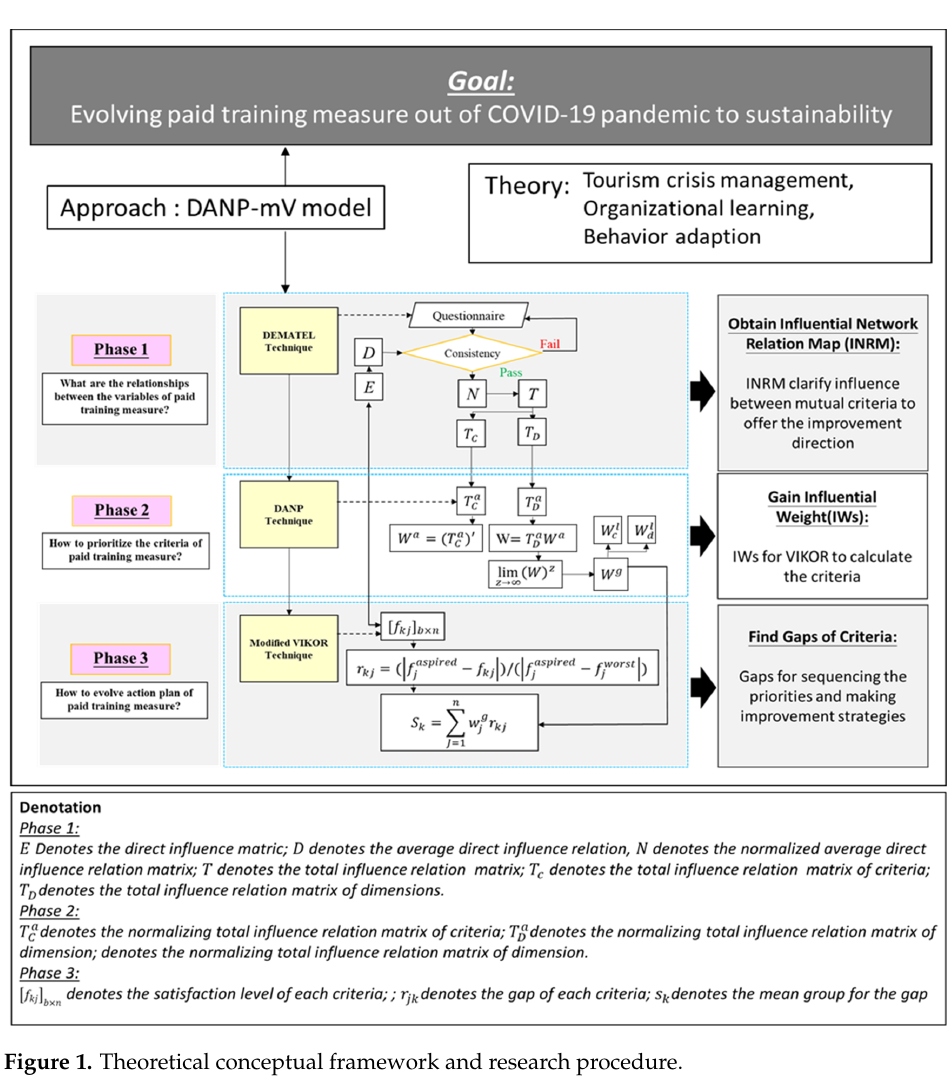
Figure 1. Theoretical conceptual framework and research procedure.